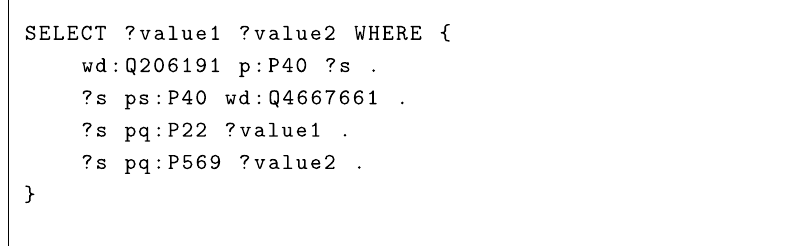
Fig. 1 Ground truth SPARQL query for the question “What is the birthday of Abigail Adams who has a child named Abigail Adams Smith?” from the Lc-QuAD 2.0